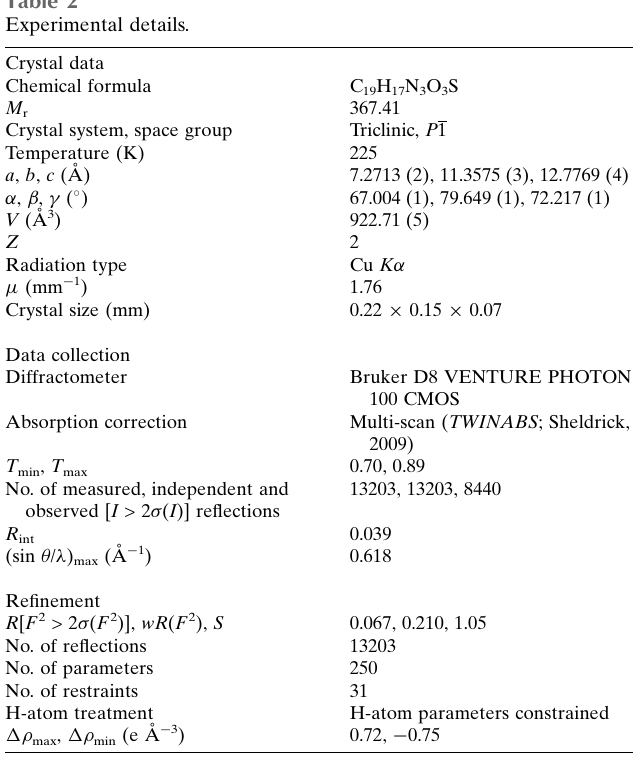
Table 2 Experimental